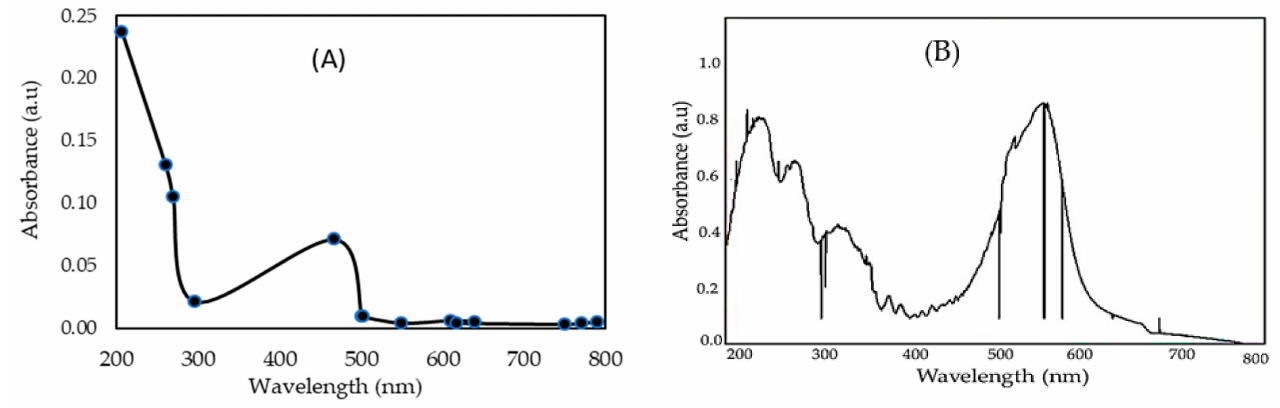
Figure 3. UV-Visible Spectrum of P. capillacea nanoparticles ( A ) and IV2R dye concentration ( B ).